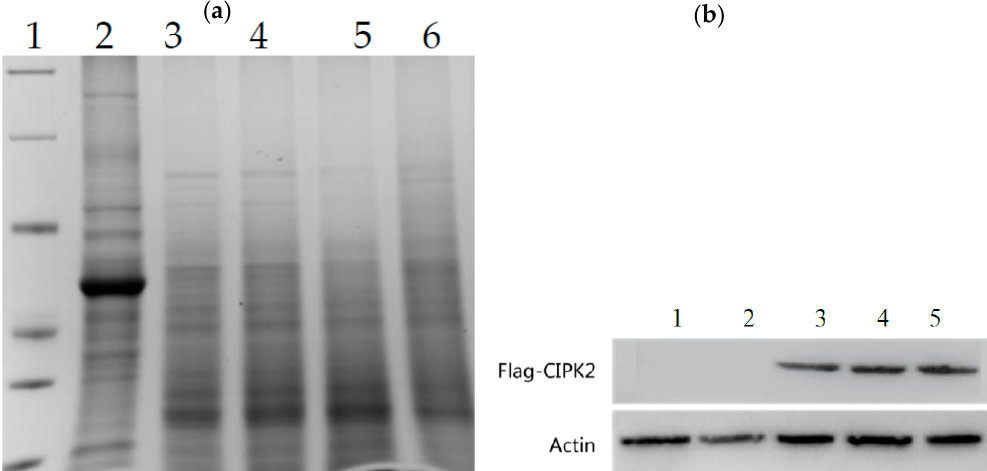
Figure 2. ( a ) SDS-PAGE test results of total protein from rice roots and leaves. Lane 1: Marker; Lane 2: RC (transgenic rice) leaves; Lane 3: WT (wild-type) roots; Lane 4–6: RC roots. ( b ) Western blot test results of Flag-CIPK2 protein in rice roots and leaves. Lane 1 RC leaves; Lane 2: WT roots; Lane 3–5: RC roots.